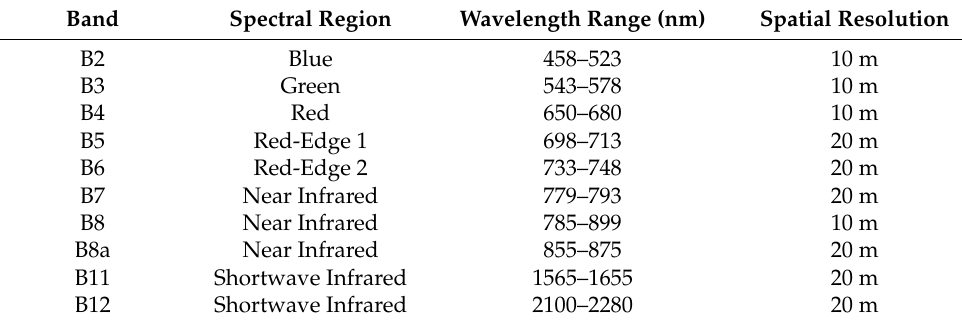
Table 3. Sentinel-2A spectral and spatial resolution of bands used in this study. Band